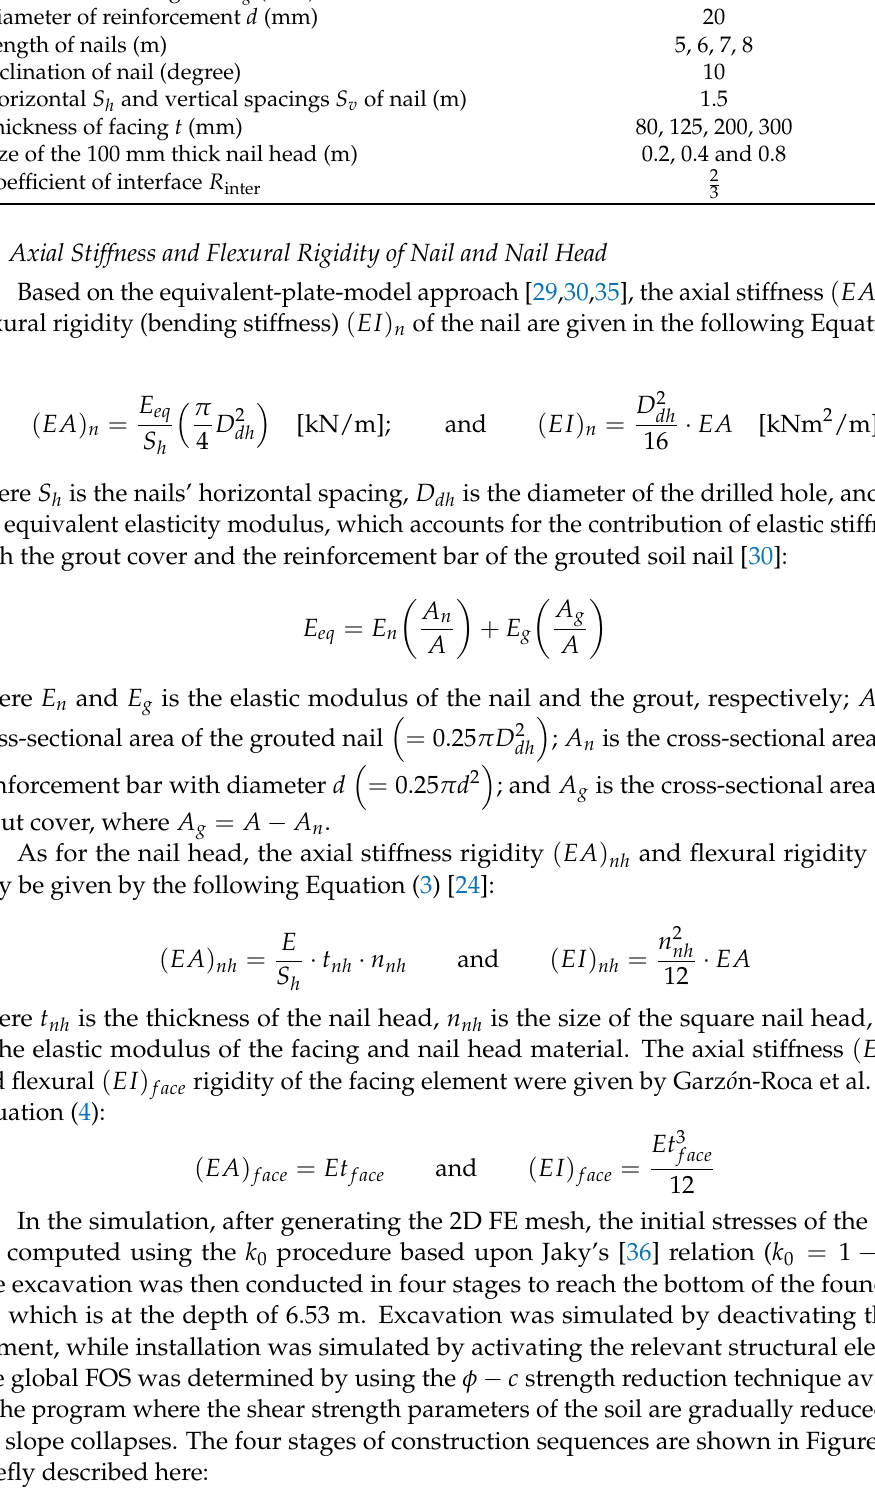
Table 2. List of soil nail and nail head parameters used in the numerical simulation. Parameter Value Yield strength of reinforcement f y (MPa) 415 Elastic modulus of reinforcement E n (GPa) 200 Elastic modulus of concrete nail head E (GPa) 34.5 Elastic modulus of grout E g (GPa) 22 Diameter of reinforcement d (mm) 20 Length of nails (m) 5, 6, 7, 8 Inclination of nail (degree) 10 Horizontal S h and vertical spacings S v of nail (m) 1.5 Thickness of facing t (mm) 80, 125, 200, 300 Size of the 100 mm thick nail head (m) 0.2, 0.4 and 0.8 Coefficient of interface R inter 2